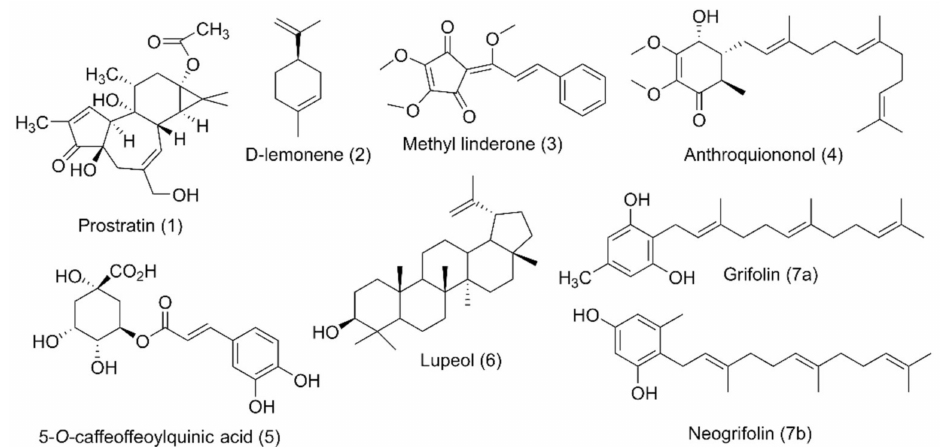
Figure 4. Carbocyclic natural product RAS